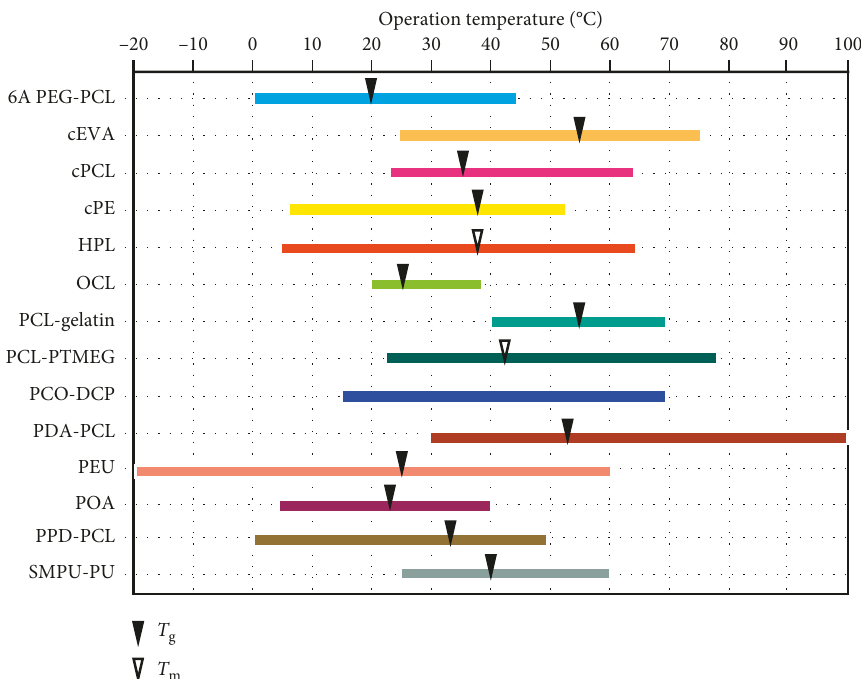
Figure 10: Temperature ranges of thermally responsive two-way